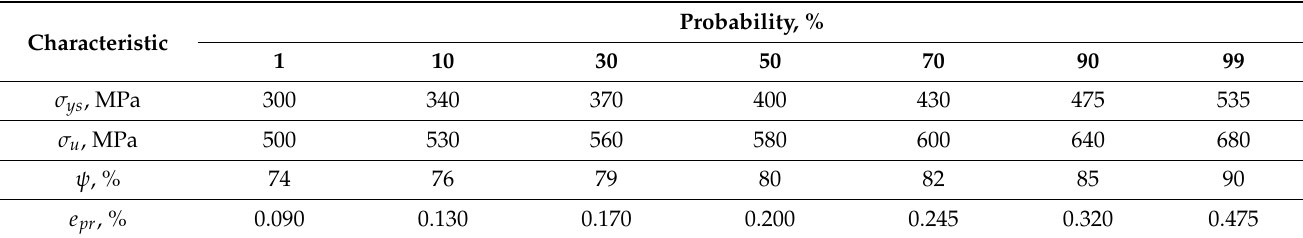
Table A1. Probabilistic values of mechanical characteristics for steel 15Cr2MoVA.